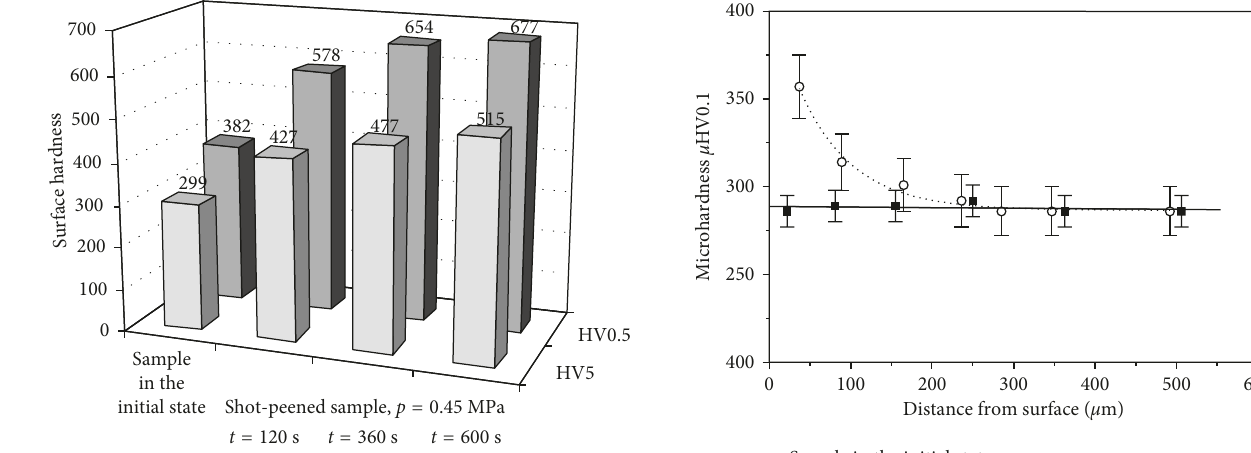
Figure 4: The surface hardness of the sample in the initial state and after the shot peening